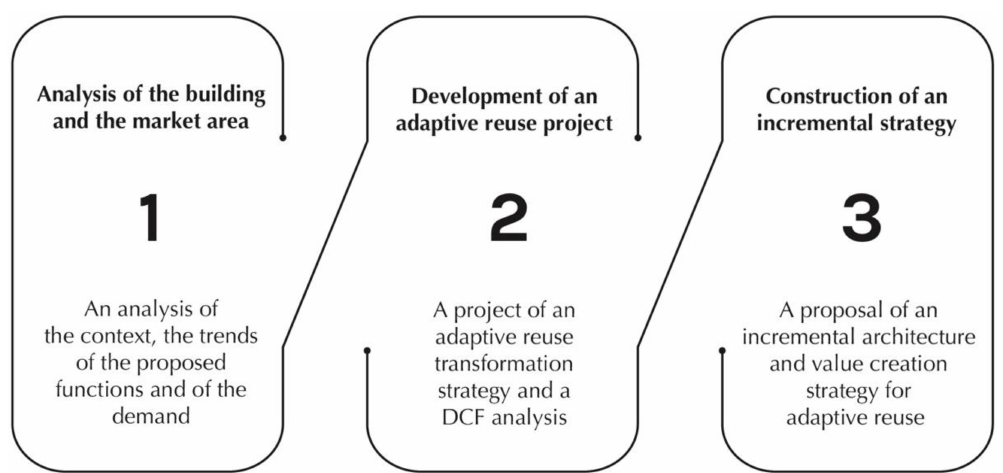
Figure 3. The phases of the